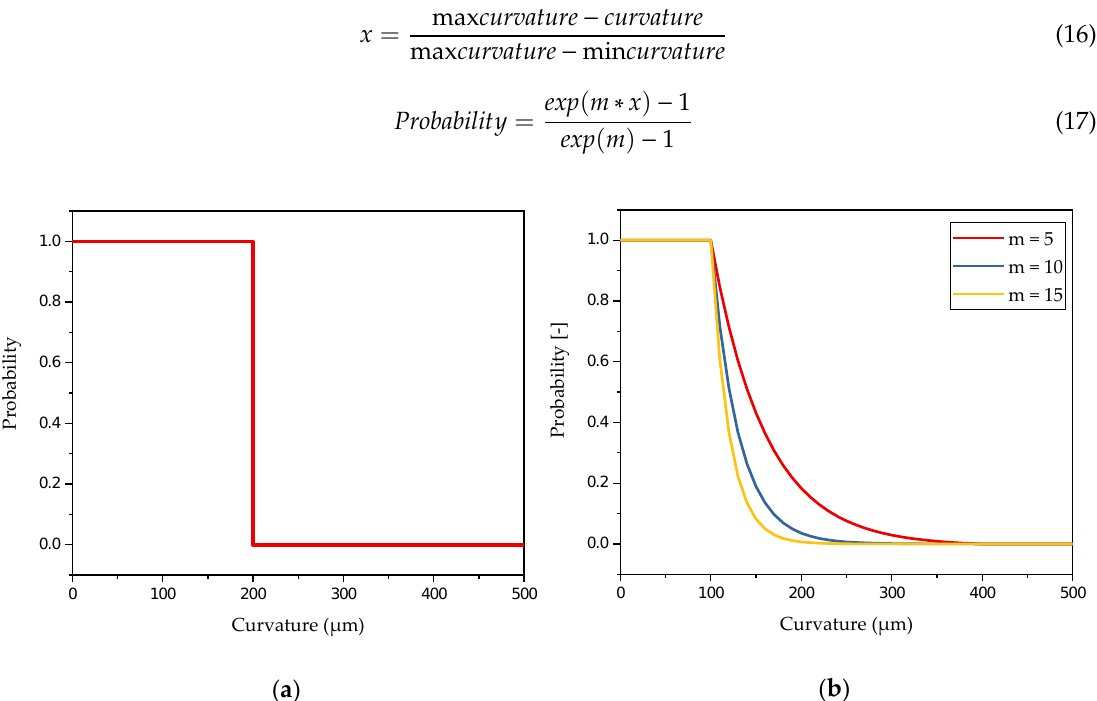
Figure 13. Different breakage models implemented in the mechanistic model: ( a ) Original breakage model; ( b ) probability breakage model when m = 15 .